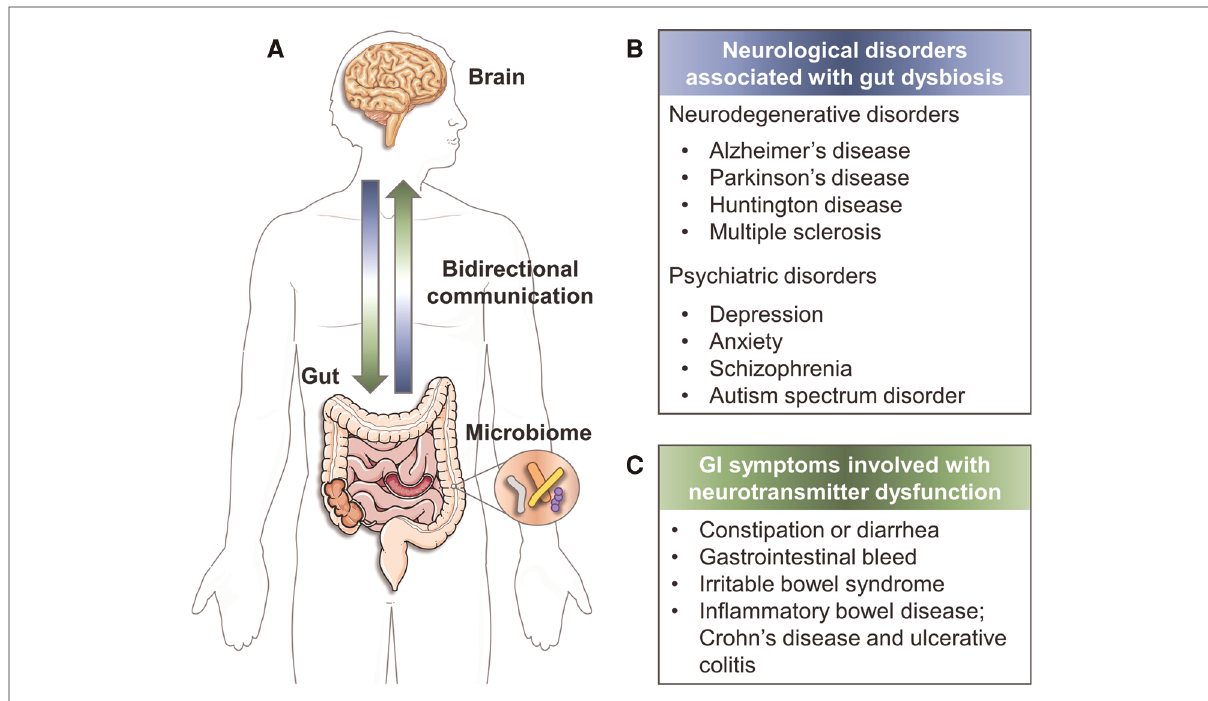
FIGURE 1 The bidirectional GBA. ( A ) The reciprocal communication between gut and brain. ( B ) Neurological disorders associated with gut dysbiosis (3). ( C ) GI symptoms involved with neurotransmitter dysfunction (4, 5). (created with Servier Medical Art;